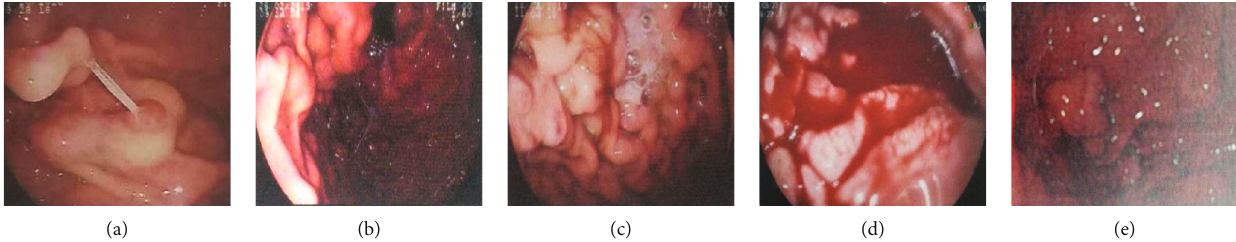
Figure 2: EGD regarding varices in fi ve LPSH patients. (a) EGD of case 1 (TL) demonstrating multiple gastric varices with a red color sign. (b) EGD of case 2 (YC) demonstrating multiple varices in the stomach with a red color sign. (c) EGD of case 3 (WZ) demonstrating multiple gastric varices with a red color sign and bloodstain. (d) EGD of case 4 (JH) demonstrating multiple gastric varices with bloodstain. (e) EGD of case 5 (HW) demonstrating multiple gastric